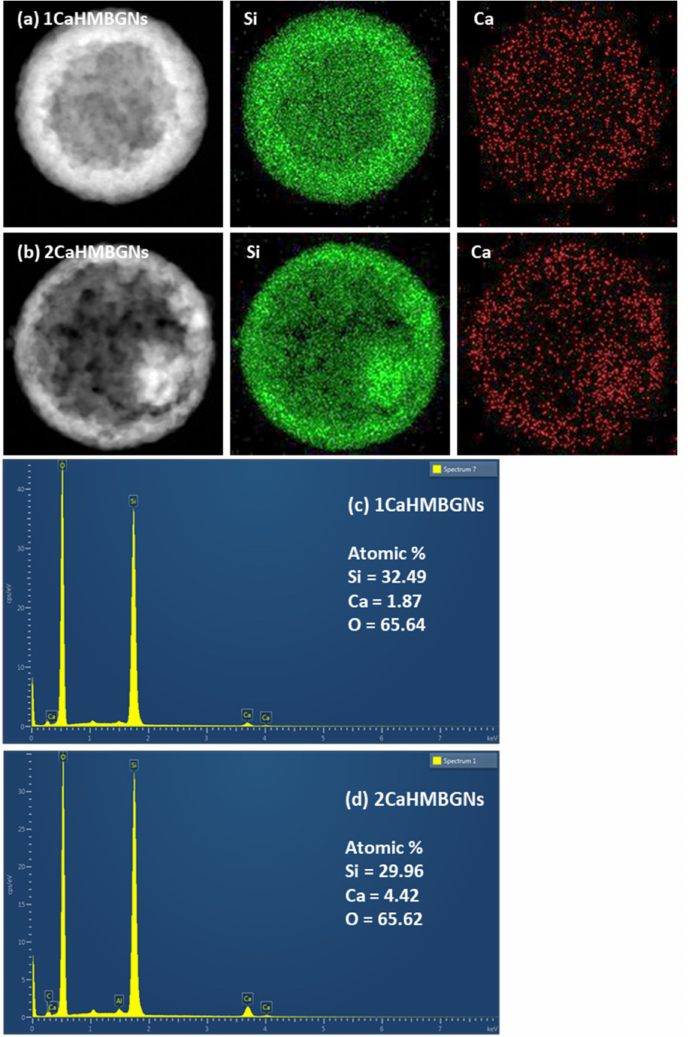
Figure 4. EDS mapping of ( a ) 1CaHMBGNs and ( b ) 2CaHMBGNs; and EDS spectra of ( c ) 1CaHM- BGNs and ( d ) 2CaHMBGNs. The size of particles shown in (a) and (b) is ~400